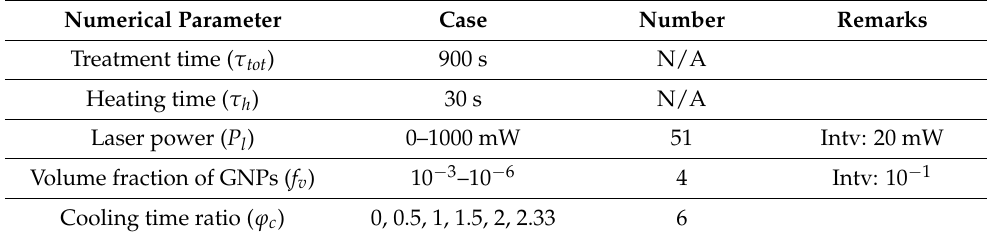
Table 2. Conditions of the numerical analysis.